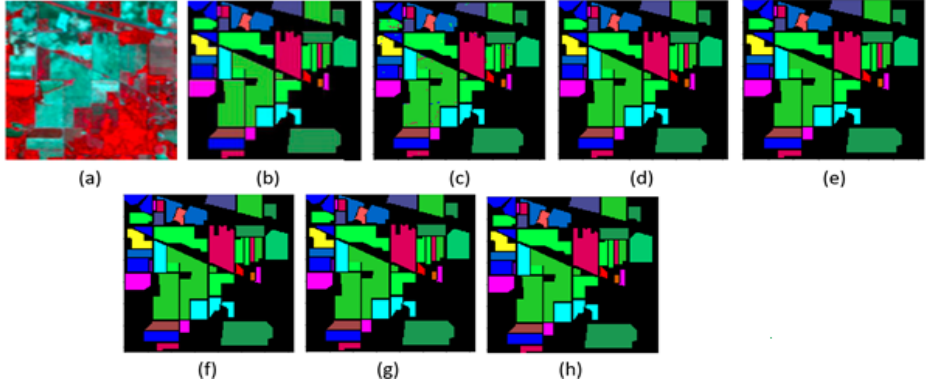
Figure 6. The training convergence performance .